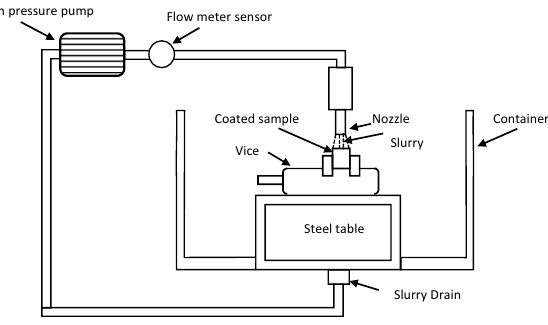
Figure 2. Schematic diagram of the erosion test set-up.